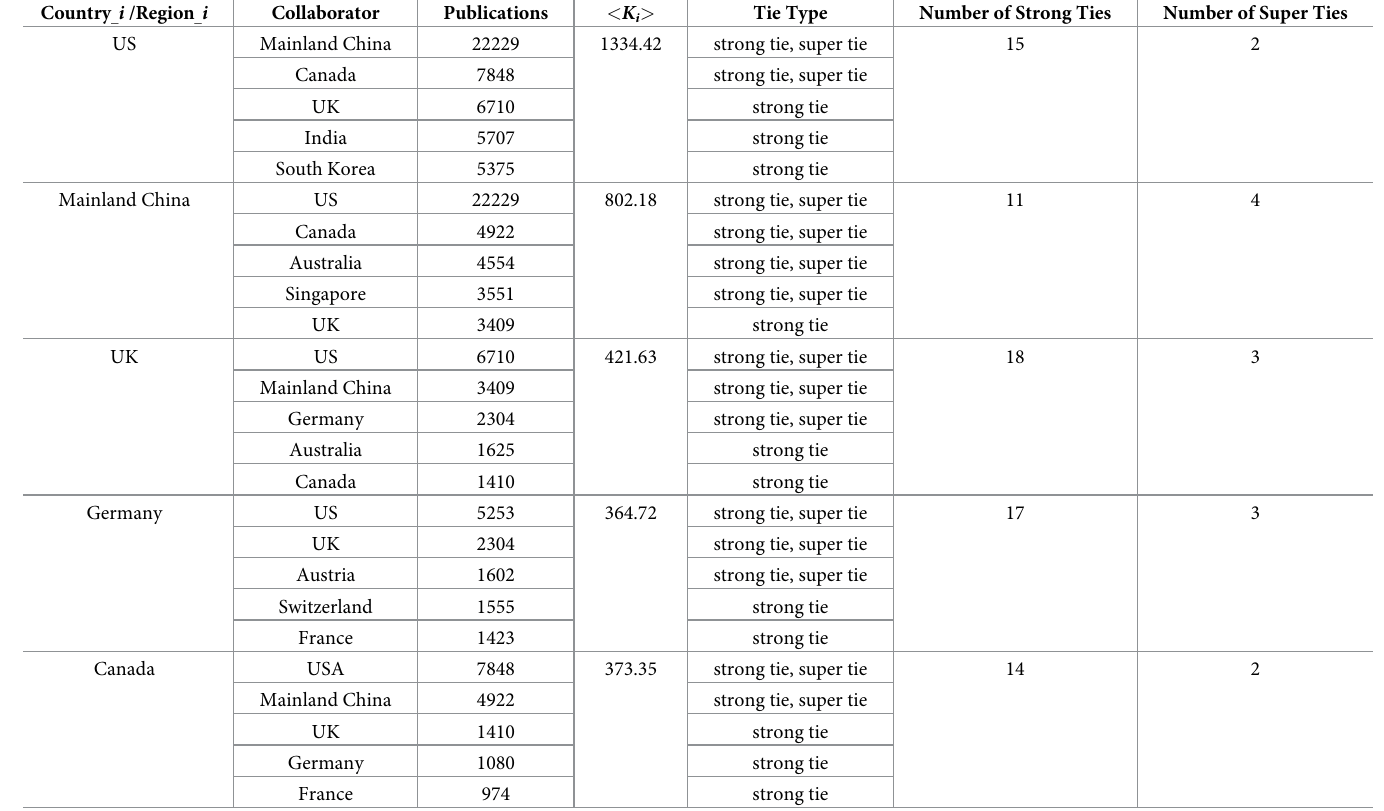
Table 2. Collaboration by high-productivity countries/regions. Country _ i /Region _